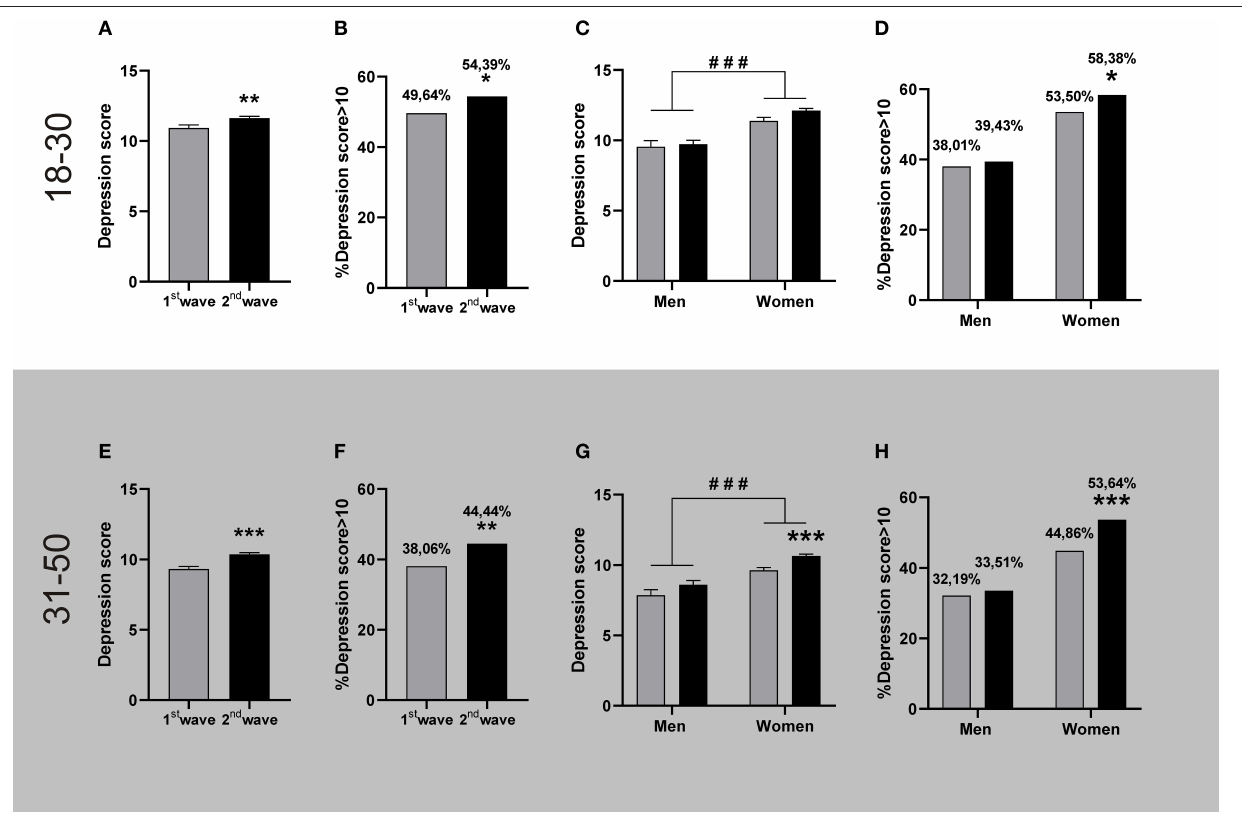
FIGURE 2 | Depression levels registered during the first and the second wave of COVID-19. The figures show the mean + SEM depression score or the percentage of people with depression scores > 10 during the first (grey bars) and the second (black bars) wave. The descriptive statistics are reported in Supplementary Table 2 . Top panel: People aged between 18 and 30. (A) People reported higher depression scores during the 2nd wave ( n = 1,844) than in the 1st wave ( n = 685). Mann-Whitney U -test, ** p < 0.01; Cohen’s d = 0.11. (B) More people presented depression scores > 10 during the 2nd wave; * p < 0.05, X 2 , ϕ = 0.042. (C) Both genders reported equivalent GAD levels in both waves, and women reported higher GAD than men within each wave, ### p < 0.001 women vs. men, after two-way ANOVA; η 2 p = 0.018 for the gender (Women: 1st wave n = 514, 2nd wave n = 1,456. Men: 1st wave n = 171, 2nd wave n = 388). (D) A higher percentage of women reported depression scores > 10 during the 2nd wave; * p < 0.05 1st wave, X 2 , ϕ = 0.043 for women. Bottom panel: People aged between 31 and 50. (E) People reported higher depression scores during the 2nd wave ( n = 2,732) than in the 1st wave ( n = 846). Mann-Whitney U -test, *** p < 0.001; Cohen’s d = 0.19. (F) More people presented depression scores > 10 during the 2nd wave; ** p < 0.01, X 2 , ϕ = 0.054. (G) Women reported more depression in the second wave. ### p < 0.001 women vs. men, and *** p < 0.001 vs. 1st wave, after two-way ANOVA; Cohen’s f 2 = 0.17 for women; η 2 p = 0.016 for the gender factor and η 2 p = 0.010 for wave factor. (Women: 1st wave n = 700, 2nd wave n = 2,347. Men: 1st wave n = 146, 2nd wave n = 385). (H) A higher percentage of women presented depression scores > 10 during the 2nd wave; *** p < 0.001 vs. 1st wave, X 2 , ϕ = 0.073 for